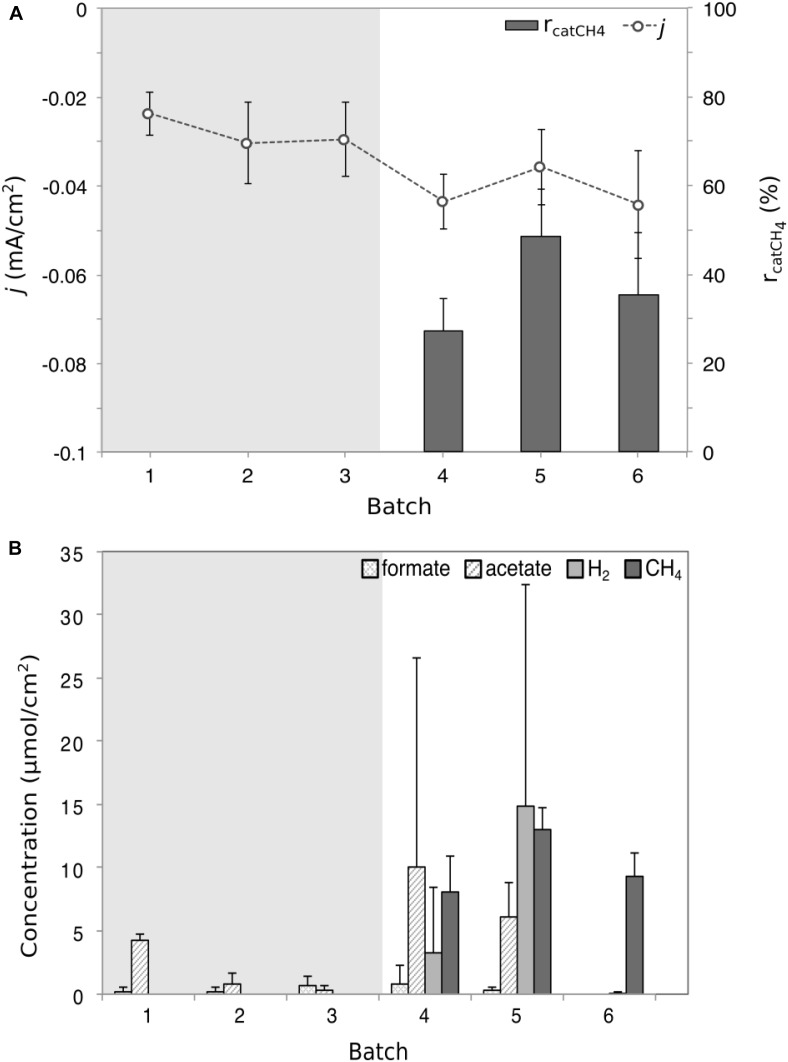
Performance and product formation plots for the microbial electrosynthesis (MES) reactor. (A) The recorded average current density j (dot and line plot) and the cathode recovery efficiency for CH4 (rcatCH4, bar chart) for the six MES batches. (B) The average concentrations of the four detected products in the form of formate, acetate, methane, and hydrogen gas. The shaded gray area indicates the period of time where gas analysis was not done; therefore no gas data were available and it was not possible to calculate rcatCH4. Each product data point represents the average (triplicate reactors) recorded for each batch test. Current density was significantly variable (ANOVA, F = 5.1, p = 0.001), as was H2 concentration (Kruskal–Wallis, χ2 = 5.1, p = 0.02) and acetate concentration (Kruskal–Wallis, χ2 = 21.9, p < 0.001).